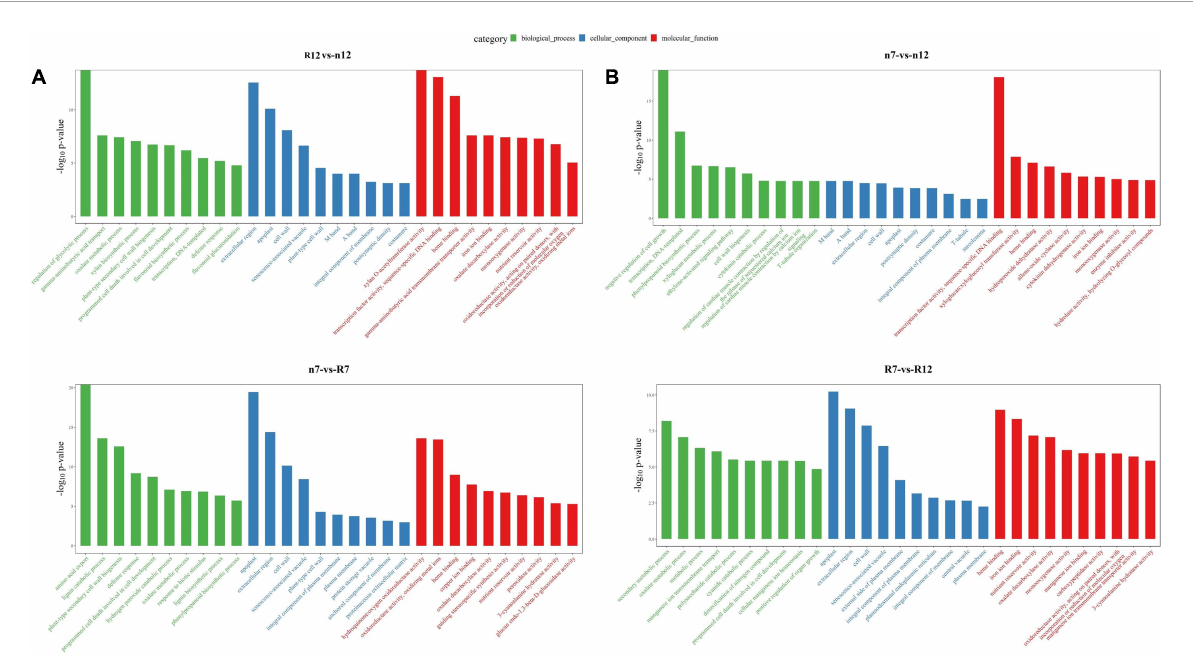
FIGURE5 Gene ontology (GO) enrichment analysis results between different comparison groups (A) R12 vs. n12, n7 vs. R7. (B) n7 vs. n12, R7 vs. R12. n7, R7, n12, and R12 represent 70 DAP and 125 DAP sampling time points under nR and RR